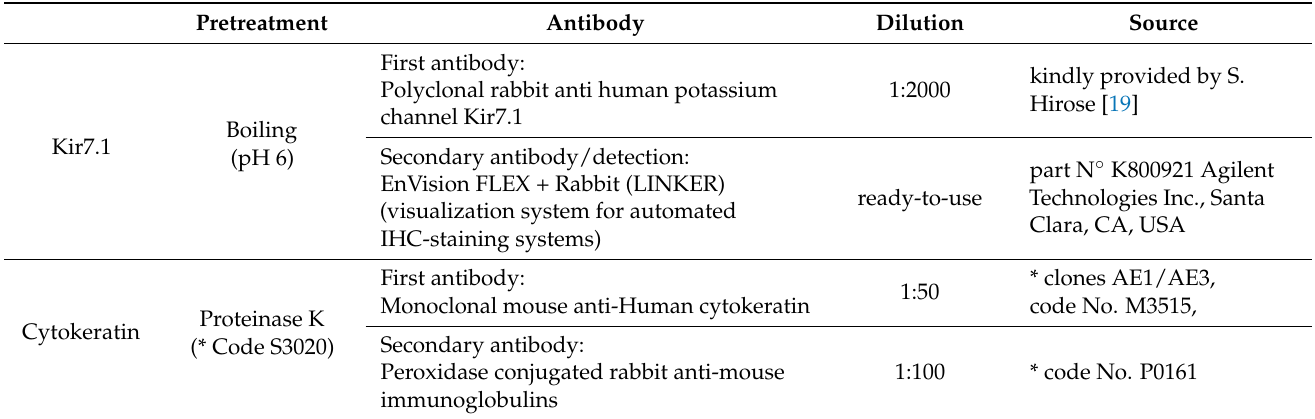
Figure 5. Diffuse, invasive choroid plexus carcinoma involving the entire central nervous system of the dog. Histopathological sections of the formalin fixed brain ( A , B ) and spinal cord with meninges and spinal nerve roots ( C – E ) on HE and immunohistochemistry for detection of Kir7.1 ( D , E ). In ( A ), a transverse brain section at the level of the rostral colliculi is shown, highlighting the subgross tumor foci (arrow, compare to Figure 4A,B). The detail enlargement of the tumor (asterisk), corresponding to the location indicated by the black rectangle in ( A ), is shown in ( B ). Spinal cord with tumor invasion (asterisks) of spinal nerve roots ( C – E ). Images in ( D ) and ( E ) show immunohistochemical detection of Kir7.1 in epithelial tumor cells (brown reaction product) within the spinal cord meninges and surrounding spinal nerve roots ( D ). The image in ( E ) shows a detail enlargement of the location indicated by the black rectangle in ( D ). Table 1. Host, dilution, pretreatment, and source of antibodies used for immunohistochemical detection of Kir7.1 and cytokeratin in the present study.